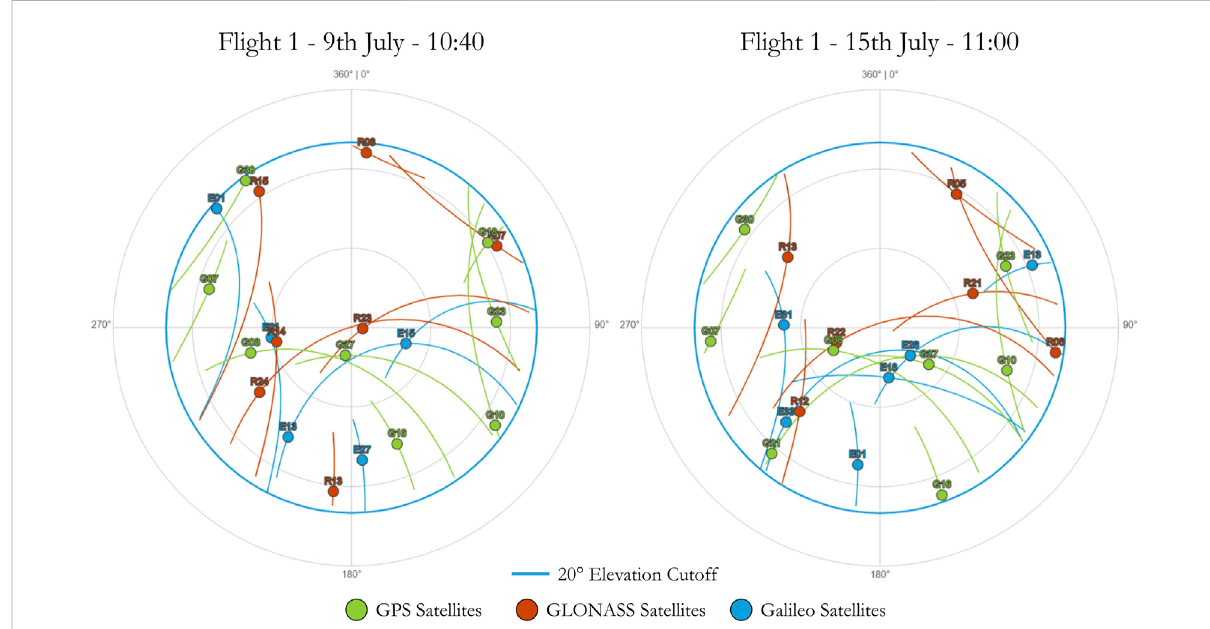
FIGURE 4 Locations of GPS, GLONASS, and Galileo satellites in the sky at the time of surveying on the 9th and 15th of July. Elevation angles of visible satelliteshasbeensetataminimumof20 ° toaccountforthevalleysidesadjacenttotheglacierwhichwouldlimittheviewingangles.Thevariationin satellitepositioncanbeseenandtheeffectthismayhaveonaccuratelydeterminingthepositionofthelaserscanner,withareductioninthenumber of high (closer to the crosshair) and northerly (0/360 ° ) satellites. Data source: https://www.gnssplanning.com.